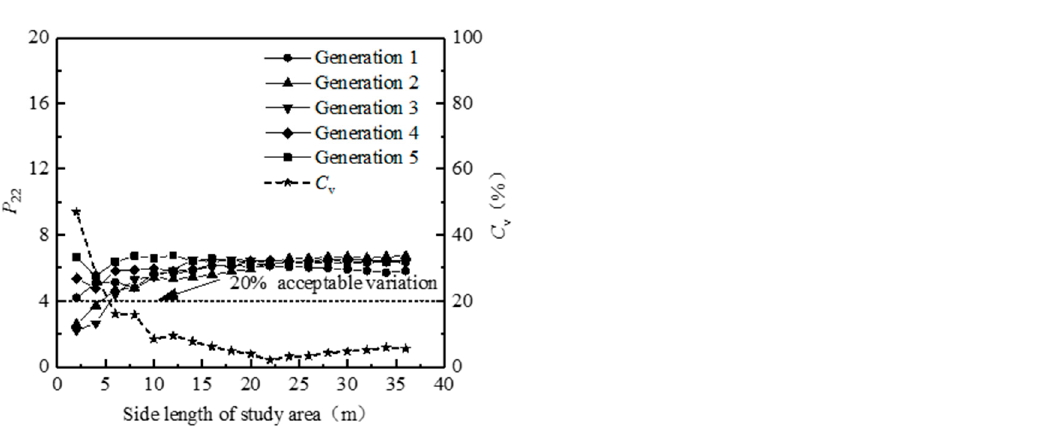
Figure 5. The fracture strength ( P 2X ) and the coefficient of variation ( C v ) versus sample size. Table 2. TREV of fractured rock mass for different equivalent parameters.